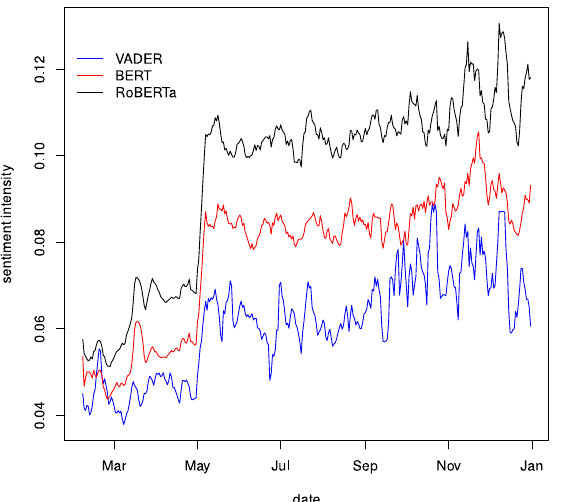
Figure A3. Year–Long time series of daily averages of positive sentiment polarity of COVID-19-related tweets in Mexico . Each line represents a time series based on the same dataset collected [6] and restricted